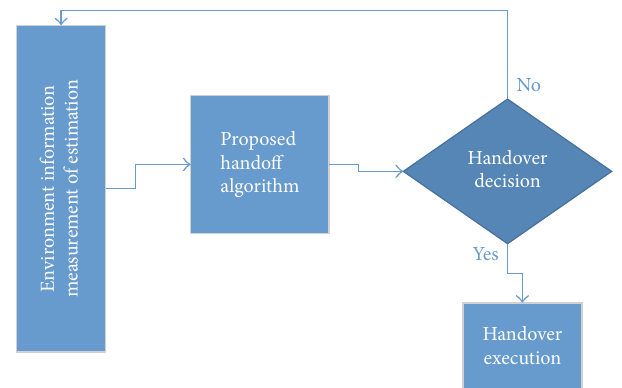
Figure 7: General structure of the proposed multicriteria handoff algorithm.